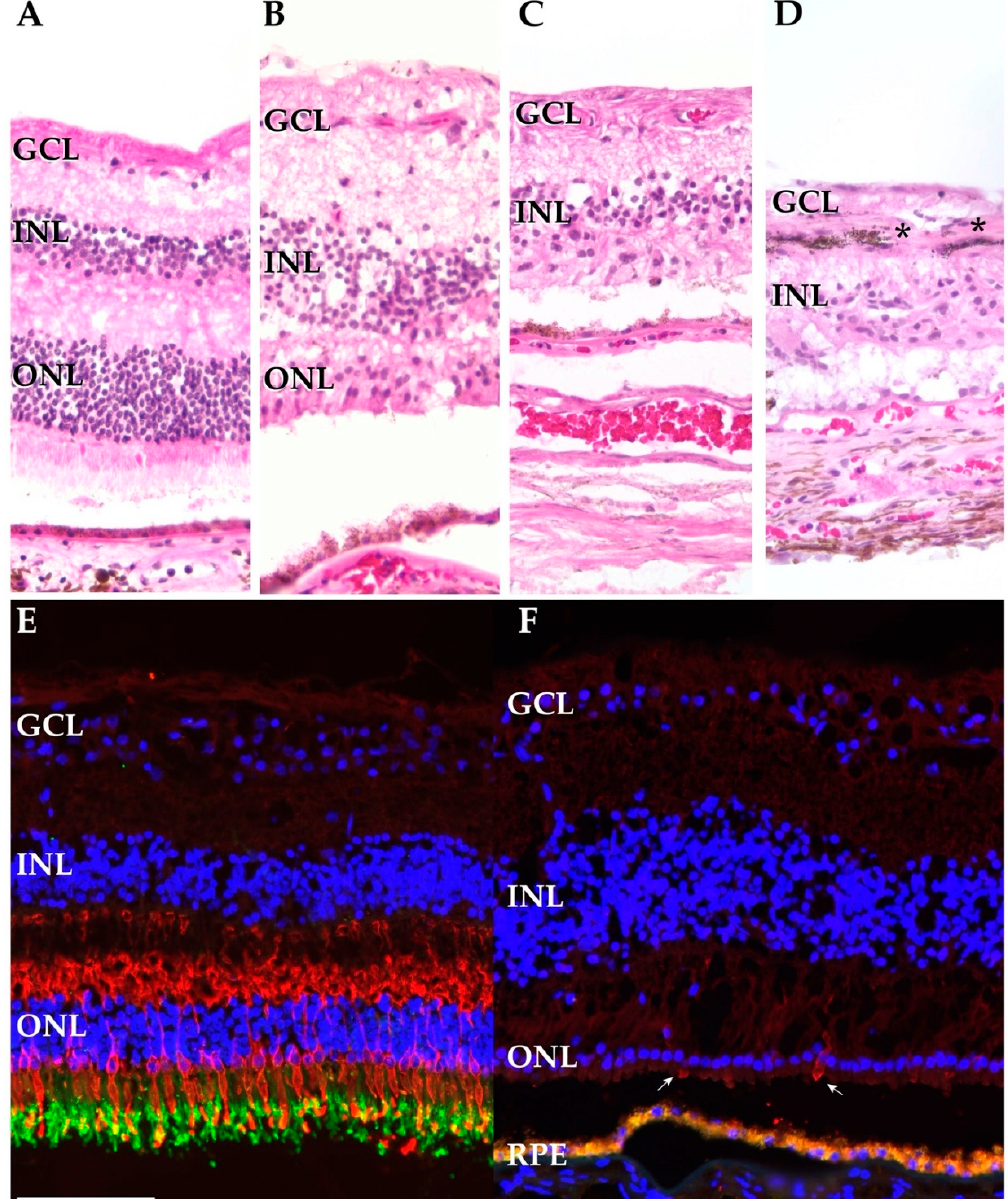
Figure 2. Histological and immunohistochemical investigation of the autoimmune retinopathy (AIR) and control donors. ( A – D ). Hematoxylin and eosin staining of the AIR and control donors. Sections from the periphery of a control donor (donor 2) ( A ), the macula (OD) of the AIR donor ( B ), and the periphery of the AIR donor ( C , D ). The AIR macula demonstrates intact ganglion cell and inner nuclear layers with attenuated cone photoreceptor outer segments. In contrast, in the periphery of the AIR donor complete loss of the outer nuclear layer ( C ) and retinal pigment epithelium (RPE) pigment migration into the inner retina ( D ) is observed (*). ( E , F ): Cone opsins (blue cone opsin and red / green cone opsins) are labeled in red while RetP1 is labeled in green. ( E ): A macula from a donor with normal ocular history demonstrates abundant labeling of cone opsins and rhodopsin. Of note, the RPE below the photoreceptors is out of frame. ( F ) The macula from the AIR donor demonstrates a complete lack of rod photoreceptors with rare, extremely attenuated cone photoreceptors (arrows). Autofluorescent lipofuscin from the RPE appears below the photoreceptor cells. Scalebar (100 microns) for all subpanels is provided in ( E ).